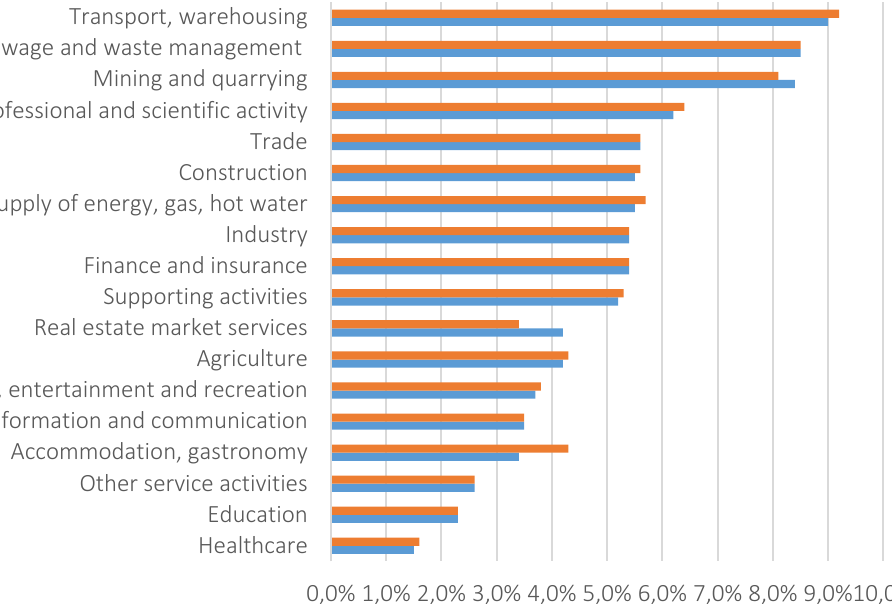
0,0% 1,0% 2,0% 3,0% 4,0% 5,0% 6,0% 7,0%